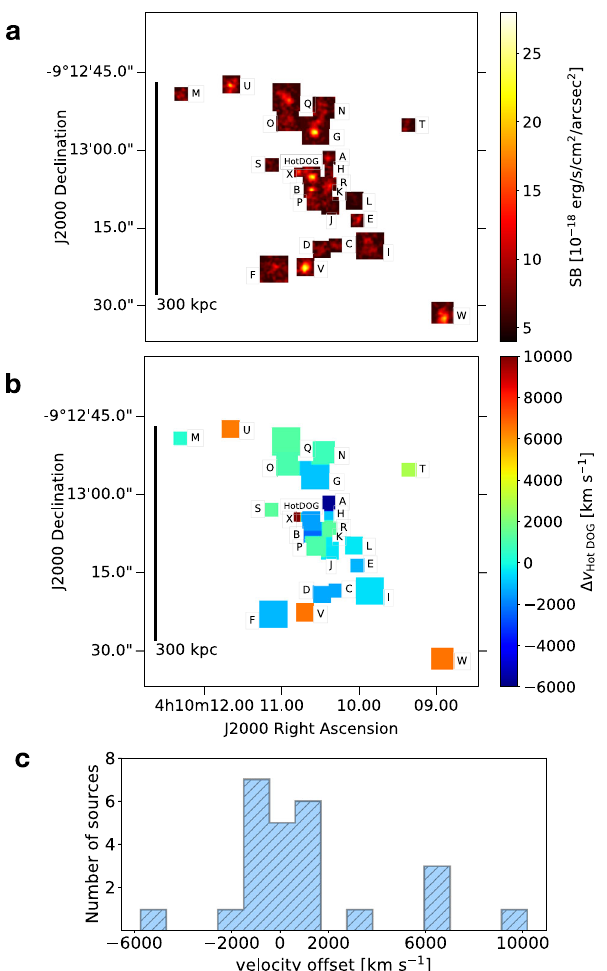
Fig. 1 | Overdensity of Lyman- α emitting galaxies in the circumgalactic envir- onment around the hyper-luminous W0410-0913, at z =3.631. a We show a collage of Lyman- α fl ux maps showing the projected spatial distribution of 24 Lyman- α -emittingcompaniongalaxiesrevealed byMUSEinthe fi eldofW0410- 0913. We applied a spatial Gaussian fi ltering of 1 pixel (0.2 ″ ) to the cutouts and we set a lower bound of SB=5×10 (cid:1) 18 ergs (cid:1) 1 cm (cid:1) 2 arcsec (cid:1) 2 in the color-scale to improve the visualization. The Lyman- α emitters are distributed on scales of about 400kpc around the W0410-0913 (see the black line, which corresponds to 300 kpc). The size of each cutout varies between 2 ″ and 4 ″ , and is chosen according to the extensions of the emitting sources. See Table 1 for the de fi - nition of IDs and a summary of the measured properties of the Lyman- α emit- ters. b We color the cutouts shown in panel a according to the offset velocities ofthecompaniongalaxieswithrespecttothesystemicredshiftofW0410-0913. The redshift of each emitter is traced by the center wavelength obtained throughaGaussian fi toftheLyman- α spectrum.ForW0410-0913,atthecenter,